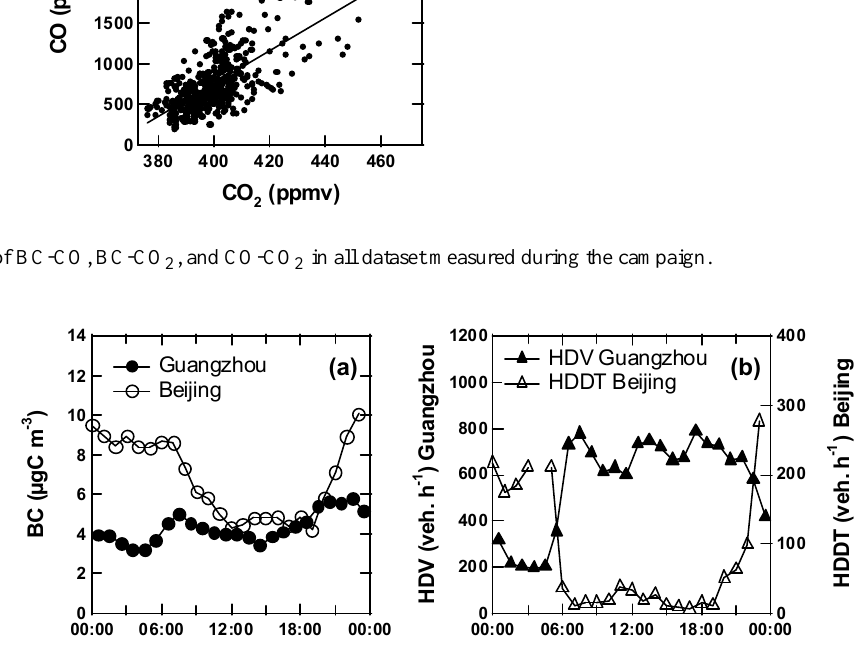
sites in Guangzhou (Fig. 10), situated at Zhongshan Univer- sity (8 km from GPEMC), Liwan (5 km), Wushan (19 km), Huangpu ( ∼ 17 km), and Longgui ( ∼ 28 km) (Duan et al., 2007; Cao et al., 2003, 2004). Hence the average BC of northerly flows represents the level of BC emissions in the PRD